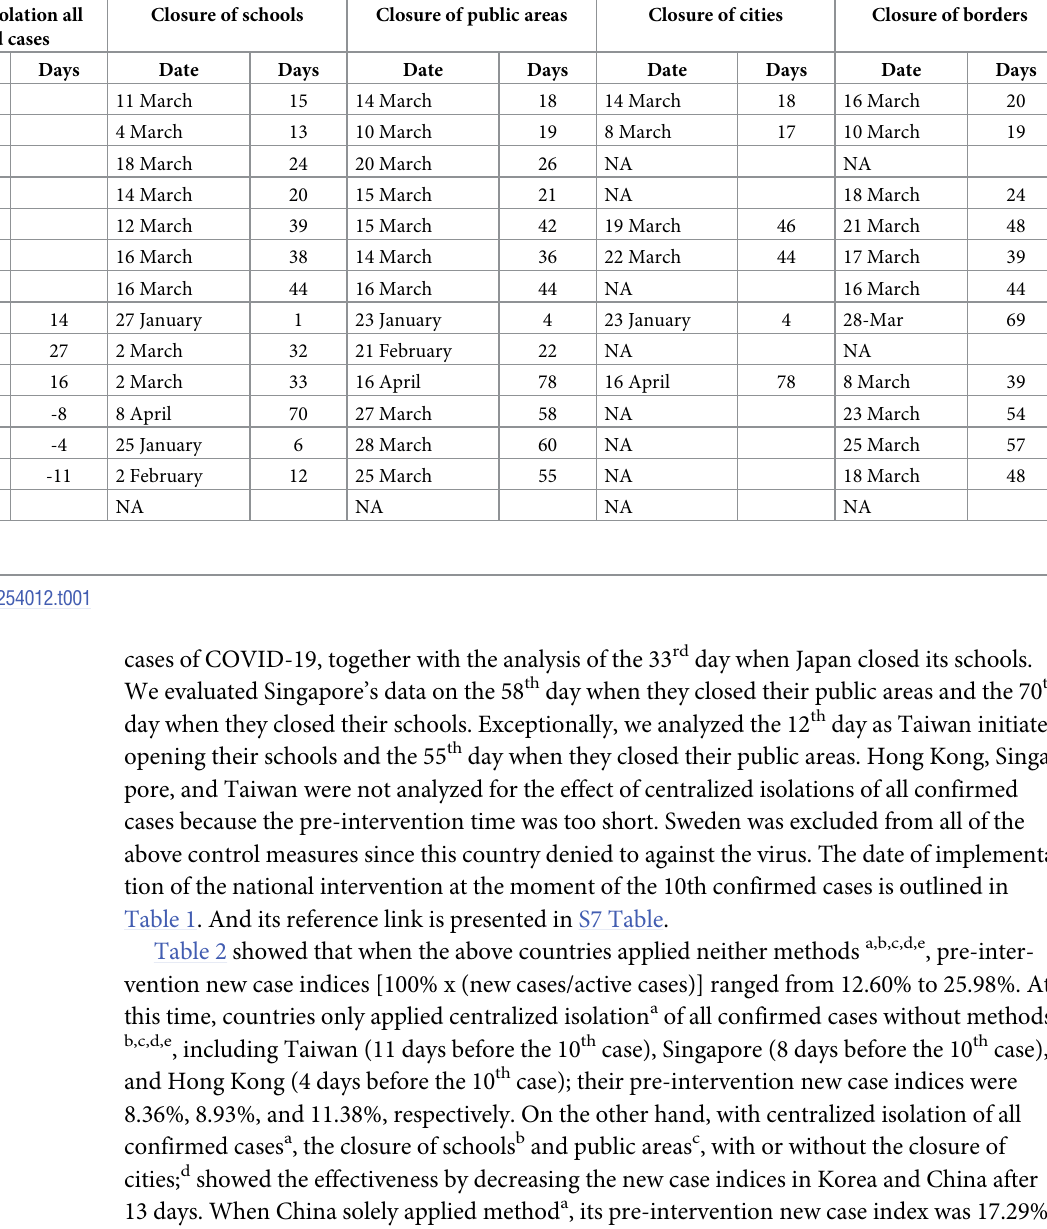
Table 1. Date of implementation of the national intervention at the moment of the 10th confirmed